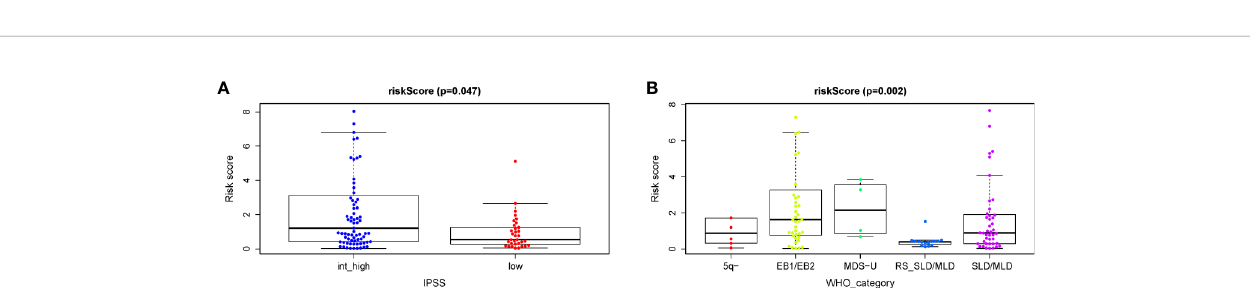
FIGURE 7 | Clinicopathological signi fi cance of the prognostic index based on the 7-ARG signature in MDS patients compared to (A) the IPSS score and (B) the WHO category.